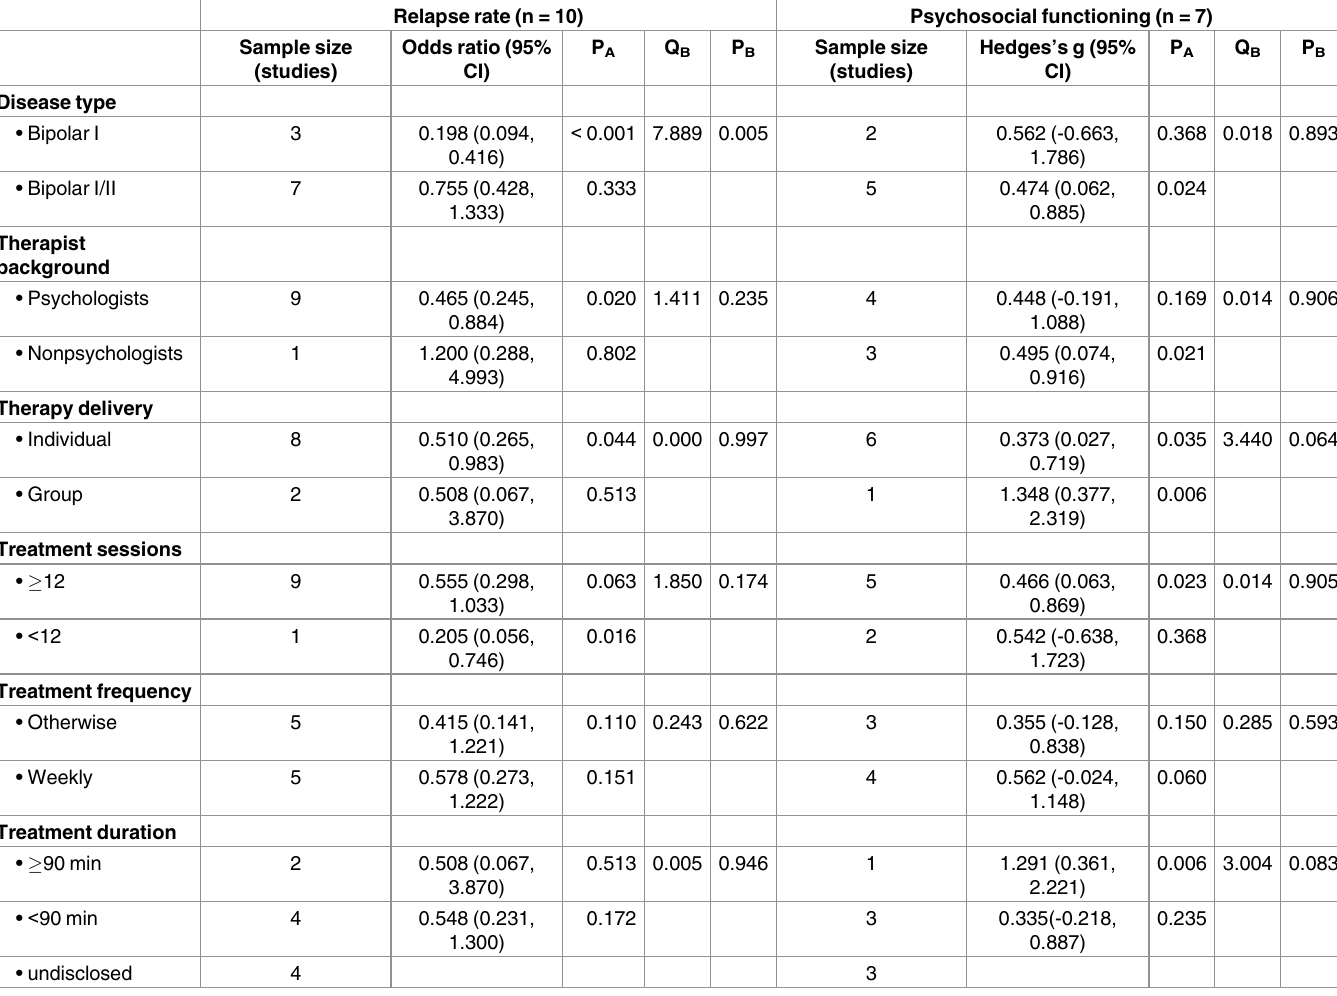
Table 4. Subgroup analysis of cognitive behavioral therapy for patients with bipolar disorder: Relapse rate and psychosocial